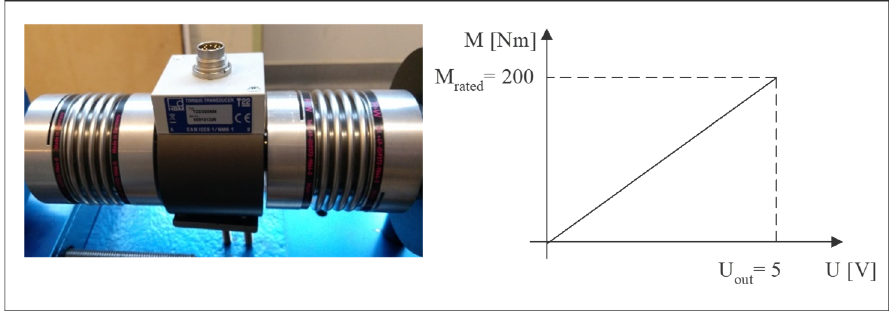
Figure 5. The rotary torque sensor and its output voltage signal.